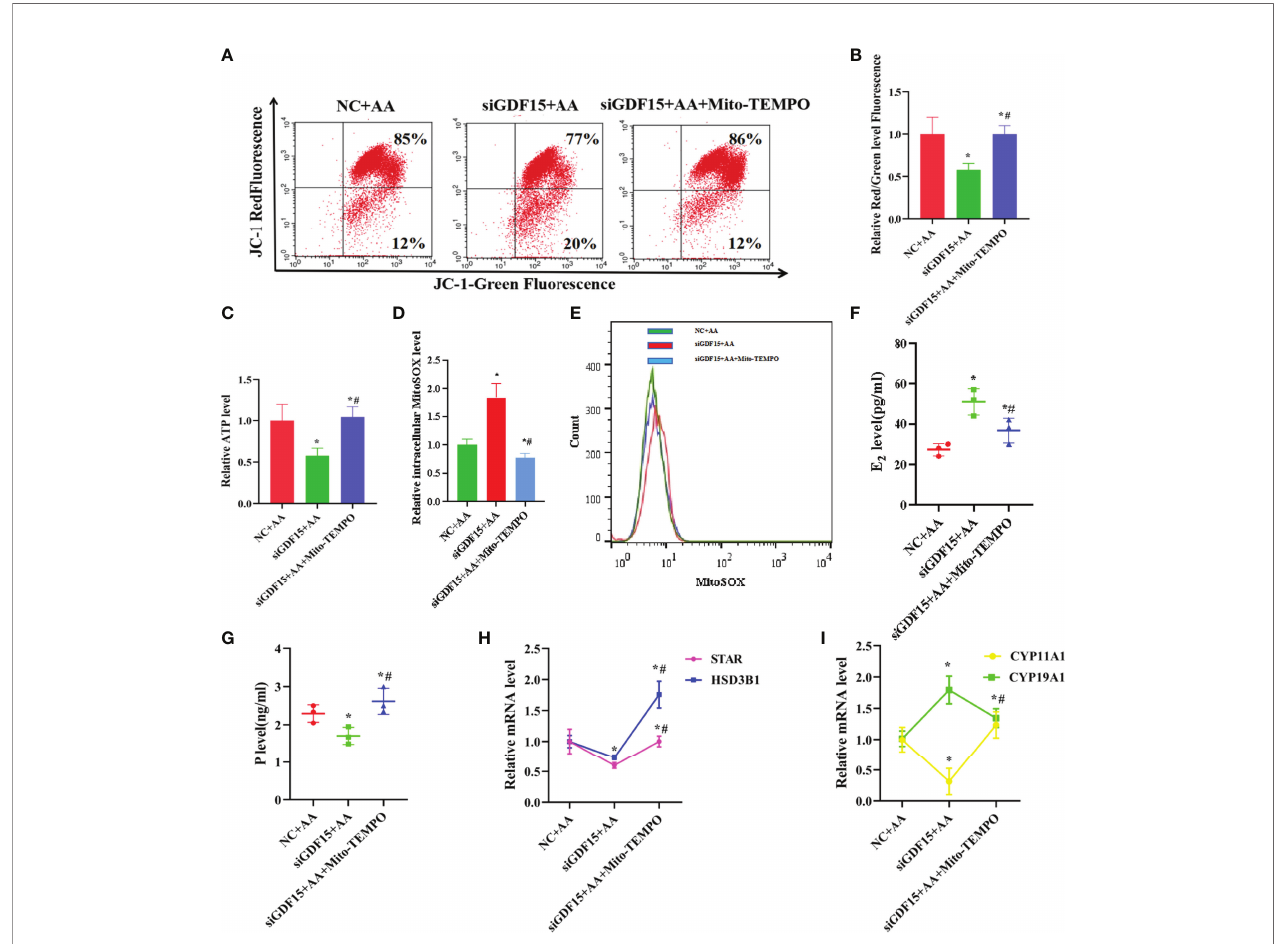
FIGURE 8 | Silencing of GDF15 caused damage to the secretory and mitochondrial function and increased apoptosis rate of KGN cells (A, B) silencing of GDF15 promoted mitochondrial dysfunction and intracellular weakened ATP level. (C) when silencing of GDF15, the mitochondrial function indicators ATP level was decreased. (D, E) when silencing of GDF15,the level of intracellular mitoSOX was increased. (F – I) silencing of GDF15 exhibited an aberrant secretion function including promoting estrogen secretion and inhibiting progesterone secretion concomitant with the upregulation of CYP19A1 and the downregulation of STAR, CYP11A1,HSD3B1. Data represent mean ± standard error, *P < 0.05, * # P <